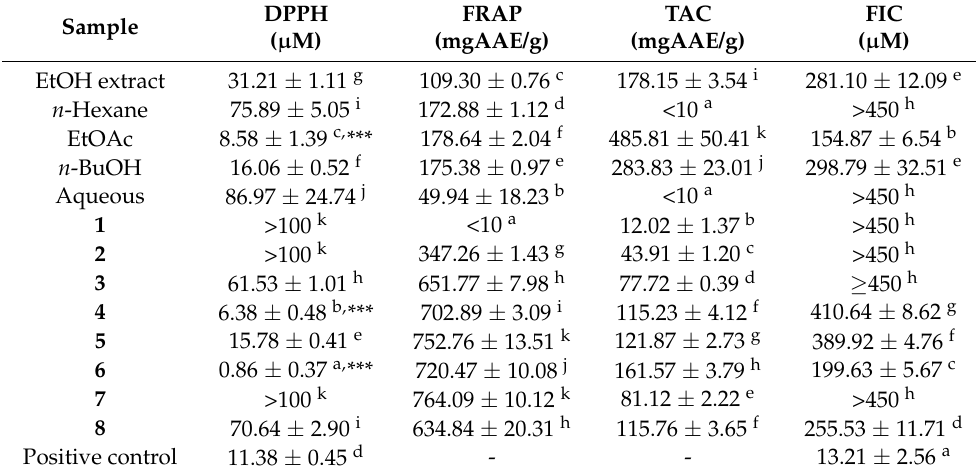
Figure 2. Qualitative antioxidant activity of G. braunii leaves by TLC-bioautography against purple DPPH radical solution. Key: G1–G6: first column bulk fractions, G3a–G3d: second column bulk fractions, 3 – 8 : isolated compounds. Table 1. Antioxidant activities of G. braunii